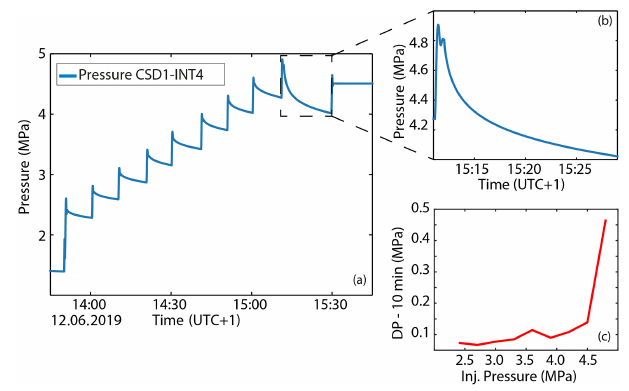
Figure 11. (a) PST in interval BCS-D1–Q4 to determine fault open- ing pressure (FOP). (b) Enlarged view of the pressure drop after reaching opening conditions; note that the decay curve is much larger when the FOP is reached. (c) Pressure changes after the 10min step vs. injection pressure: the system is nonlinear above 4.5MPa injection